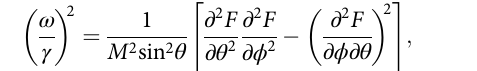
Fig. 5 Determination of Gilbert damping. Representative ferromagnetic resonance (FMR) absorption derivative spectra for the a Cr(2.8 nm)/ Co 25 Fe 75 (6.8 nm)/MgO(001) and b Cr(2.8 nm)/Co 25 Fe 75 (6.8 nm)/MAO (001) sample at ϕ H = 45° measured at f = 8 GHz, which give a FMR linewidth of 12.5 and 5.4 Oe, respectively. Frequency vs. resonance fi eld plots for the Co 25 Fe 75 fi lms on c MgO and d MAO measured at ϕ H = 45°, from which the anisotropy terms and effective saturation magnetization are extracted. e Frequency dependencies of the FMR linewidths for the Co 25 Fe 75 fi lms on MgO (red) and MAO ( blue ), where the behavior below 8 and 7 GHz, respectively, re fl ects incomplete saturation of the fi lms leading to increases in the inhomogeneous broadening. The solid lines are linear fi ts to the frequency range above 8 (7) GHz for the fi lm on MgO (MAO),